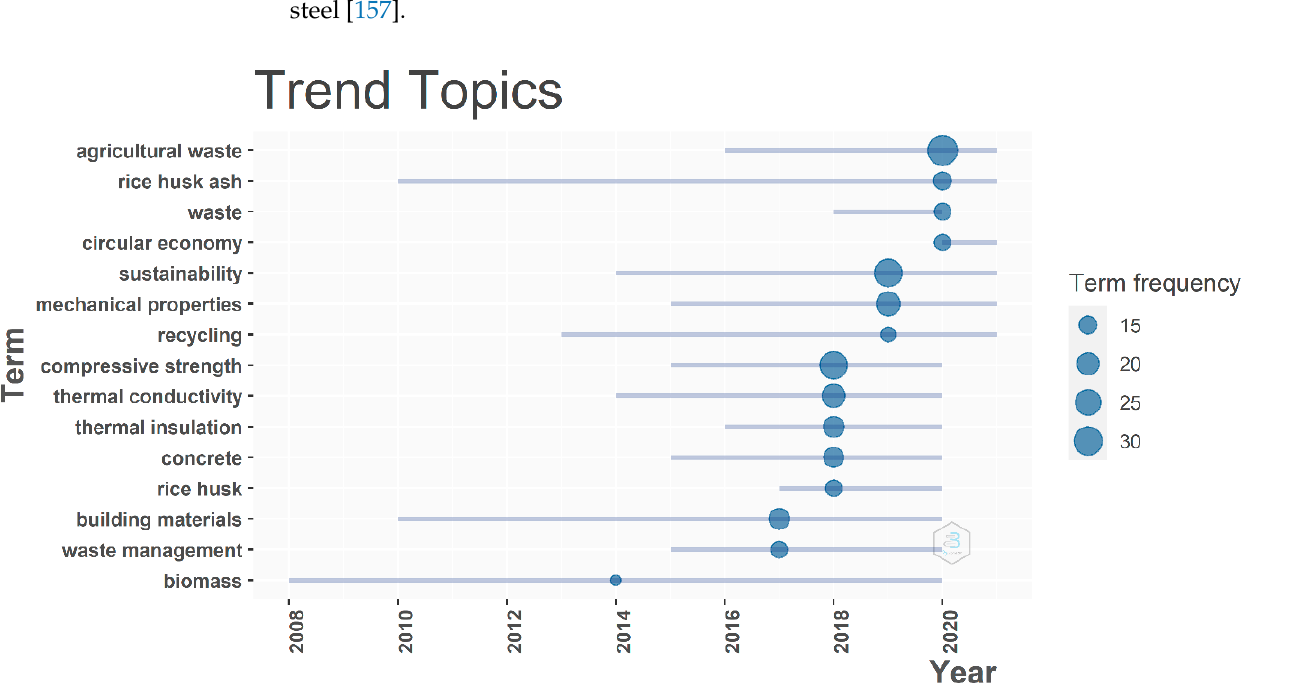
Figure 11. Trend of publications in agricultural waste as a building material.